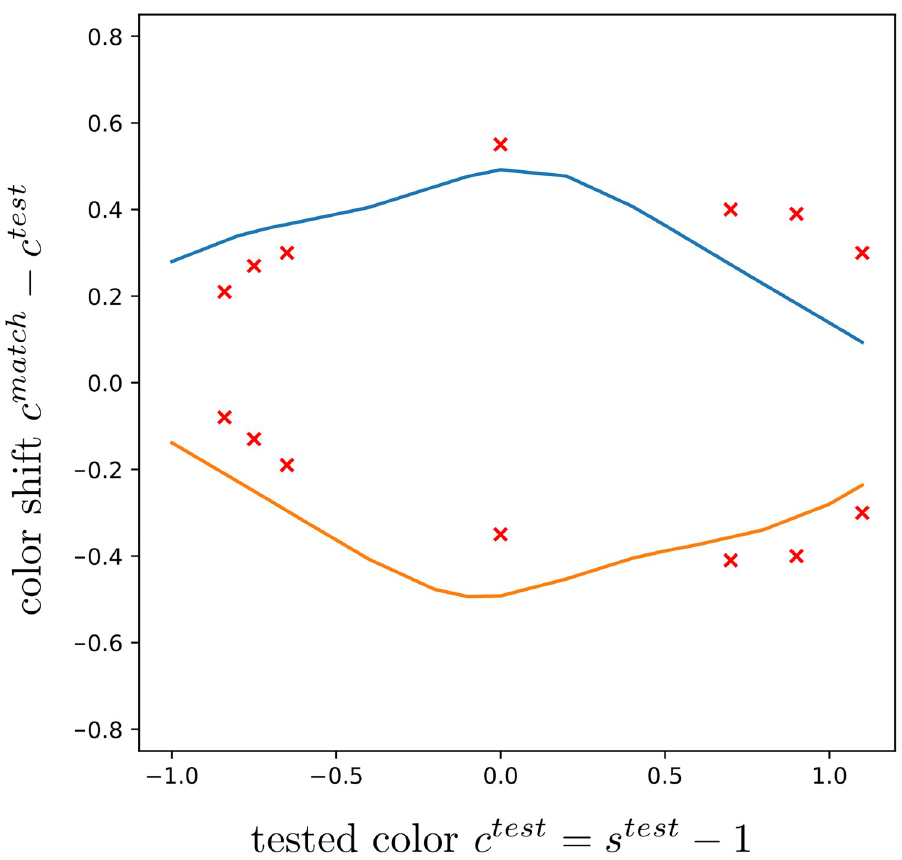
Fig 12. Our tuned model is able to reproduce nonlinear data from [17] Fig 3. The blue and orange curves correspond to our predicted shifts along the tested chromaticity given by the absicssa. The data above and below the zero line correspond to a fixed purple/lime or lime/purple pattern, respectively. Red crosses indicate the means of shifts across four subjects for seven tested values, and stand as groundtruth (refer to [17] for details).